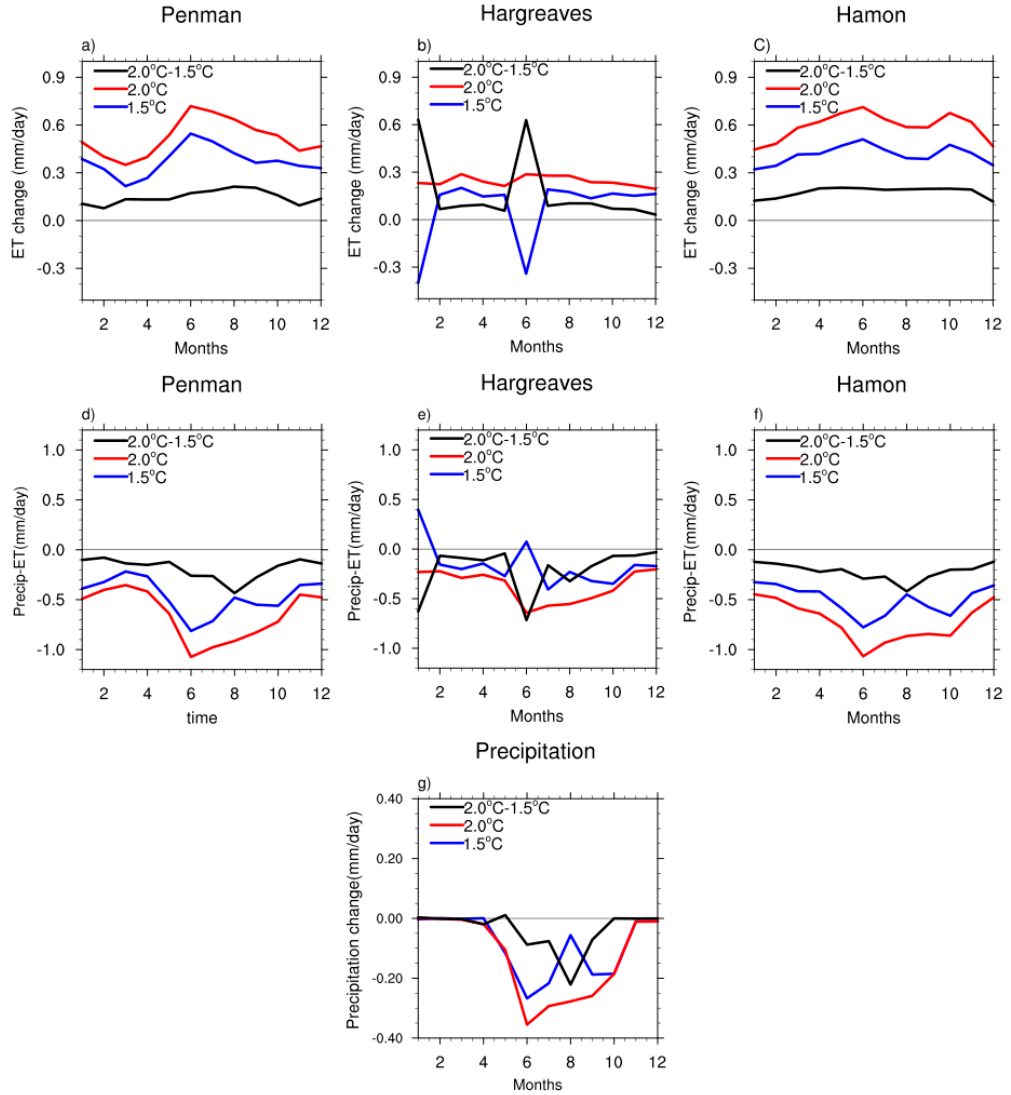
Figure 8. Seasonal cycle of Evapotranspiration ( a , d : Penman, Hargreaves, and Hamon), water balance (P-ET) ( b , e , g : with Penman, Hargreaves, and Hamon) and Precipitation changes ( c , f ) under 1.5 ◦ C and 2.0 ◦ C GWLs.